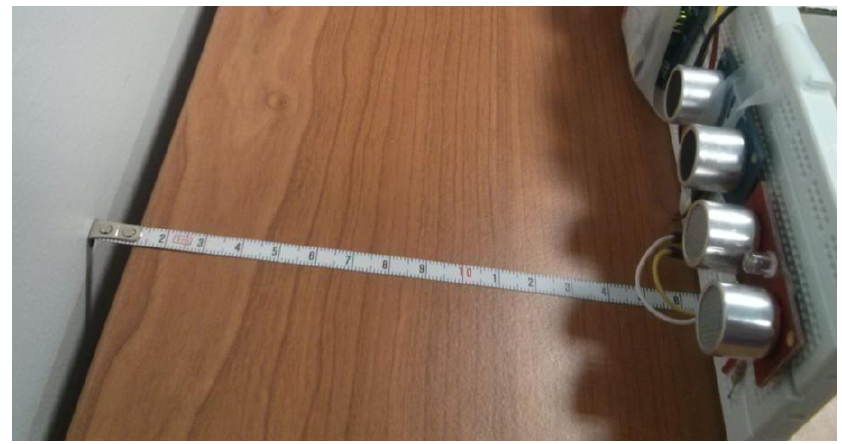
Figure 5. Short distance test of the ultrasonic distance sensors.